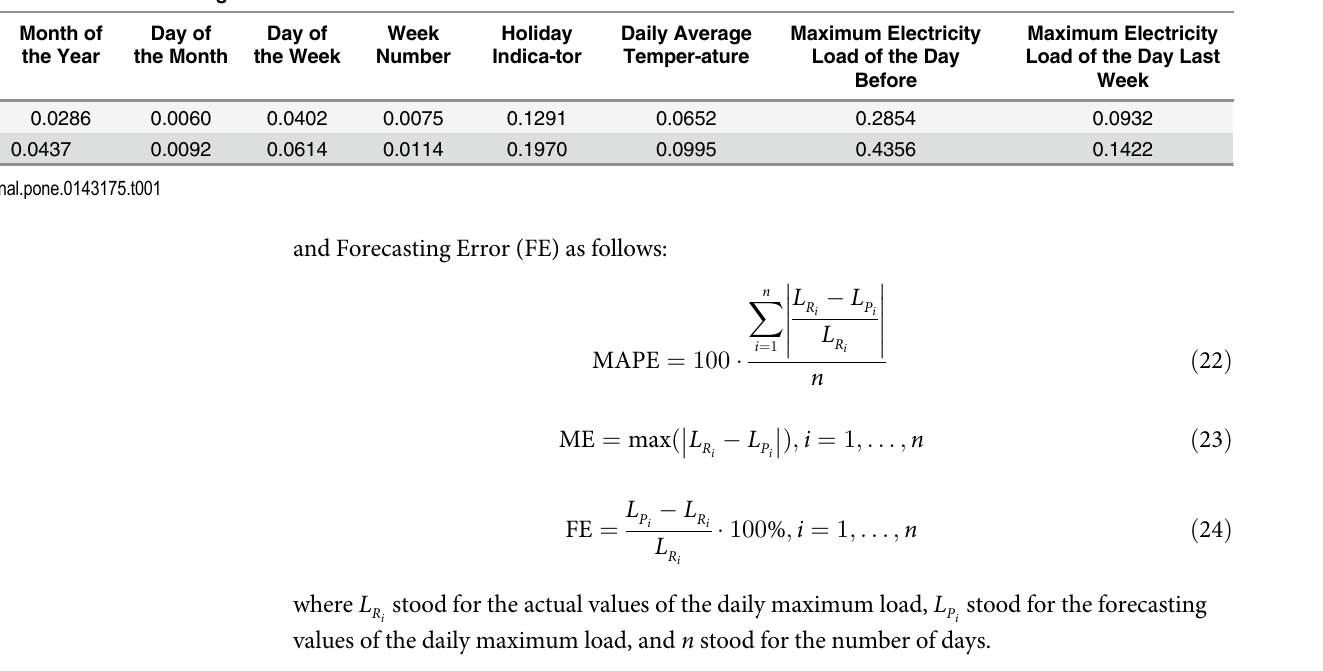
Table 1. Mutual information and weight results.